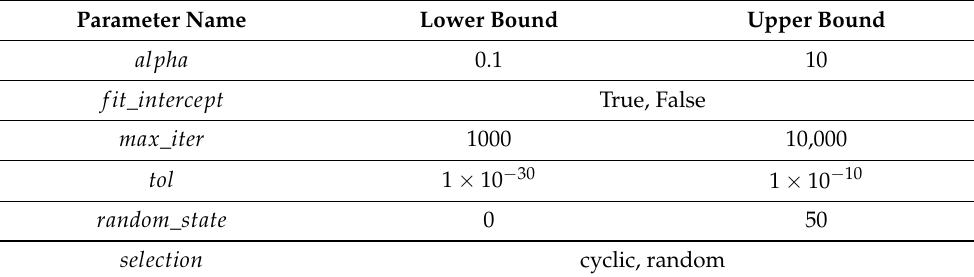
Table 8. An overview of the used hyper-parameter range for Lasso Regression Algorithm.